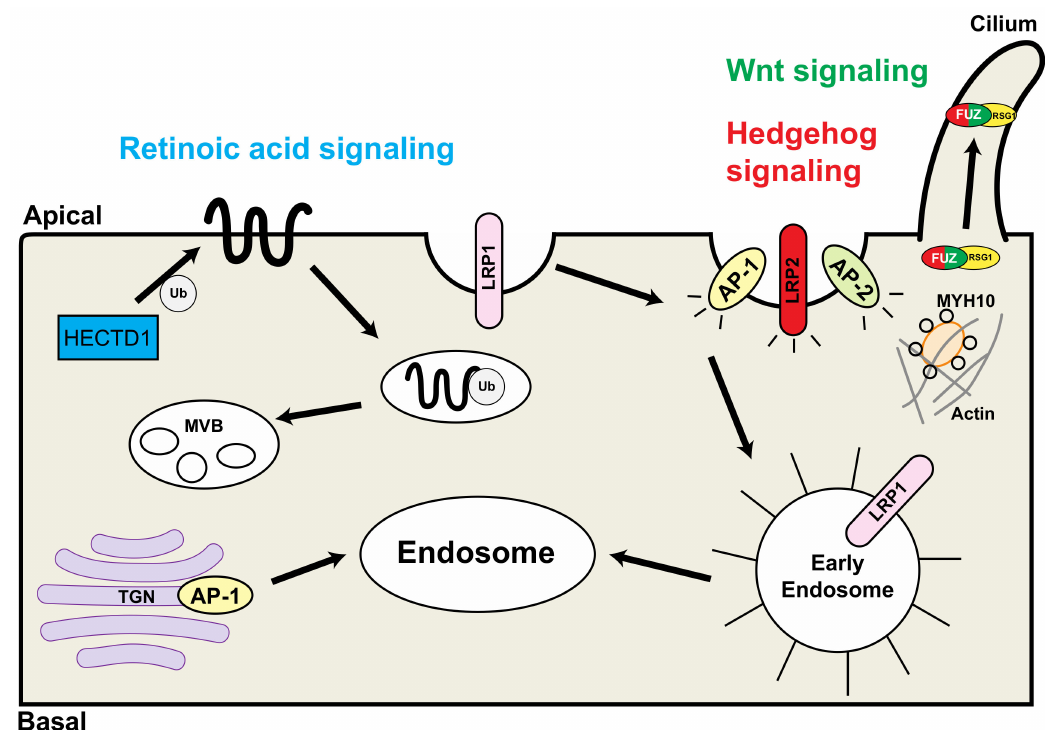
Figure 2. Schematic representation of the interaction of endocytic proteins that are associated with congenital heart defects. HECTD1 is involved in the retinoic acid pathway (blue); LRP2 and FUZ are involved in the hedgehog signaling pathway (red); FUZ is involved in the Wnt signaling pathway (green). TGN: trans-Golgi network; Ub: ubiquitin; MVB: multivesicular bodies; RSG1: RAB-like small GTPase 1. Modified from reference [20], Figure